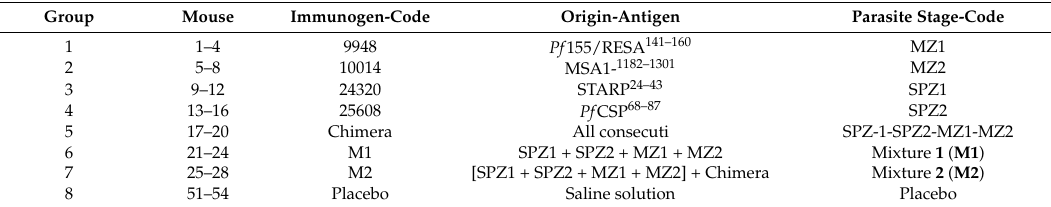
Table 2. Experimental design for immunogen formulation and animal